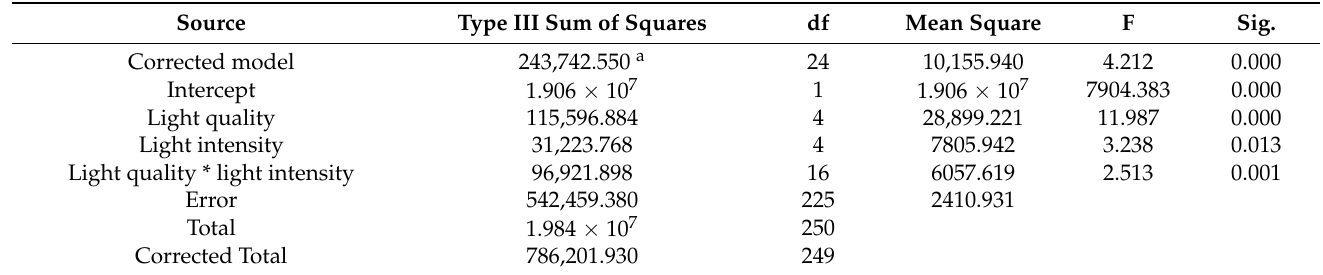
Table 2. Examination of the intrasubject effects of different light qualities and light intensities on the yield of P. eryngii